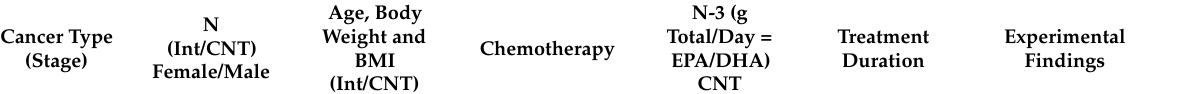
Table 1. Randomized controlled trials providing N-3 capsule supplementation concomitant with